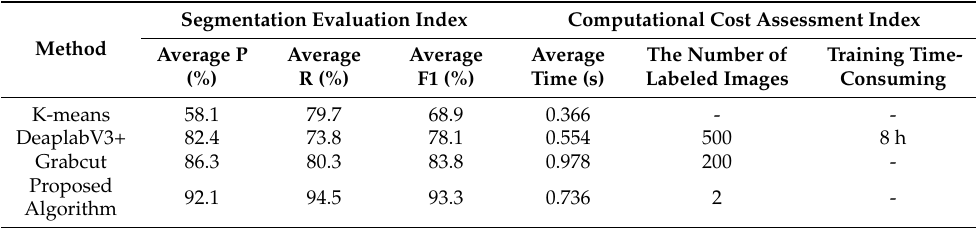
Table 1. Average results for 200 images using different algorithms.